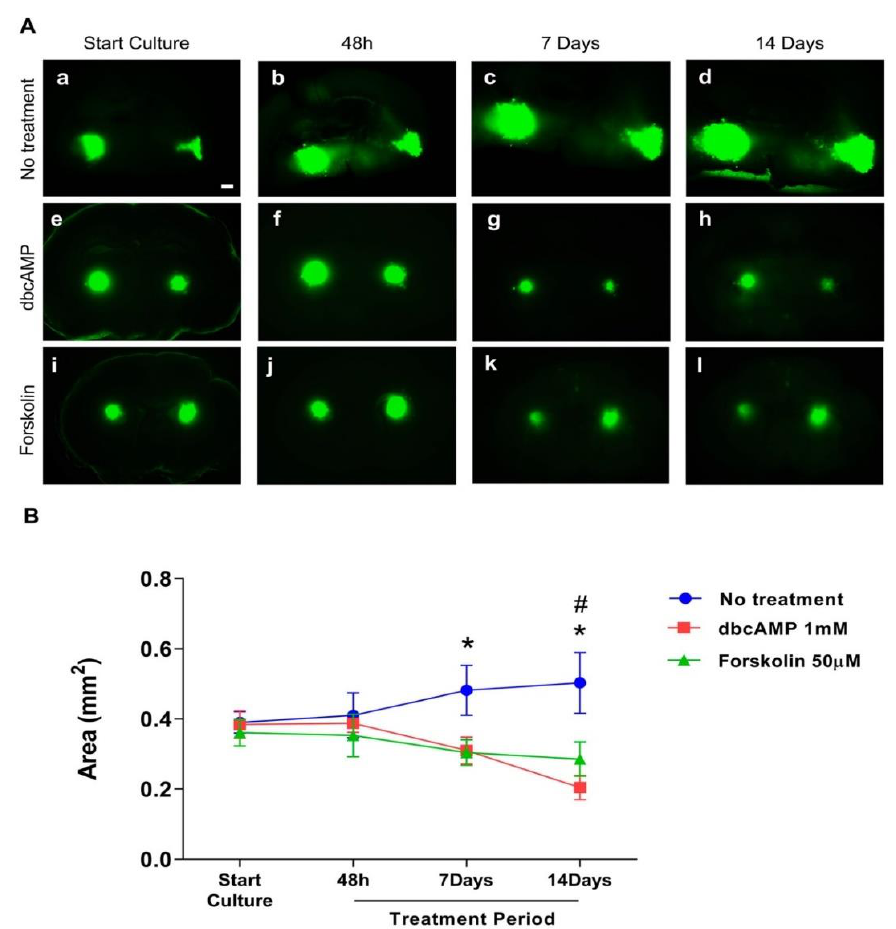
Figure 3. Effect of differentiation therapy on the tumor area of the glioblastoma cell line U87 co-cultured with organotypic brain slices. U87GFP+ cells transplanted bilaterally onto the CA3 region of the hippocampus after organotypic brain slice preparation. ( A ) Fluorescent images at the start of culture, and 48 h, 7 days, and 14 days after treatment (a–d untreated glioblastoma; e–h treatment with the cyclic AMP analog dibutyryl cAMP; i–l treatment with the cAMP activator forskolin; magnified by 5 × . The scale bar represents 500 µ m. ( B ) Graphical depiction of the results of GB area measurements with ImageJ. Group comparisons were performed by two-way ANOVA followed by a Tukey post-hoc analysis. Data are expressed as mean ± SEM (n = 8 per group). * p < 0.5 untreated tumor vs. forskolin; # p < 0.5 untreated tumor vs.